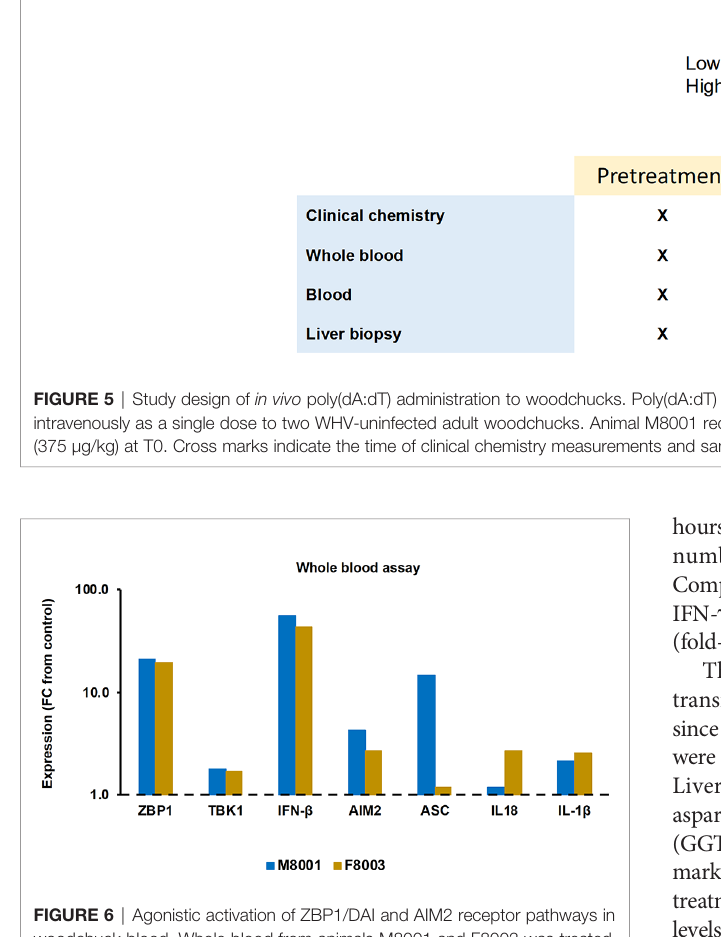
FIGURE 6 | Agonistic activation of ZBP1/DAI and AIM2 receptor pathways in woodchuck blood. Whole blood from animals M8001 and F8003 was treated with poly(dA:dT) in jetOPTIMUS transfection reagent. The fold-changes in transcript level of receptors (ZBP1/DAI and AIM2), adaptor molecules (TBK1 and ASC), and effector cytokines (IFN- b , IL-18, and IL-1 b ) after 6 hours are shown, when compared to their transcript level in transfection reagent treated control whole blood from individual animals, which was set at 1.0 and is indicated by the dotted line. FC,